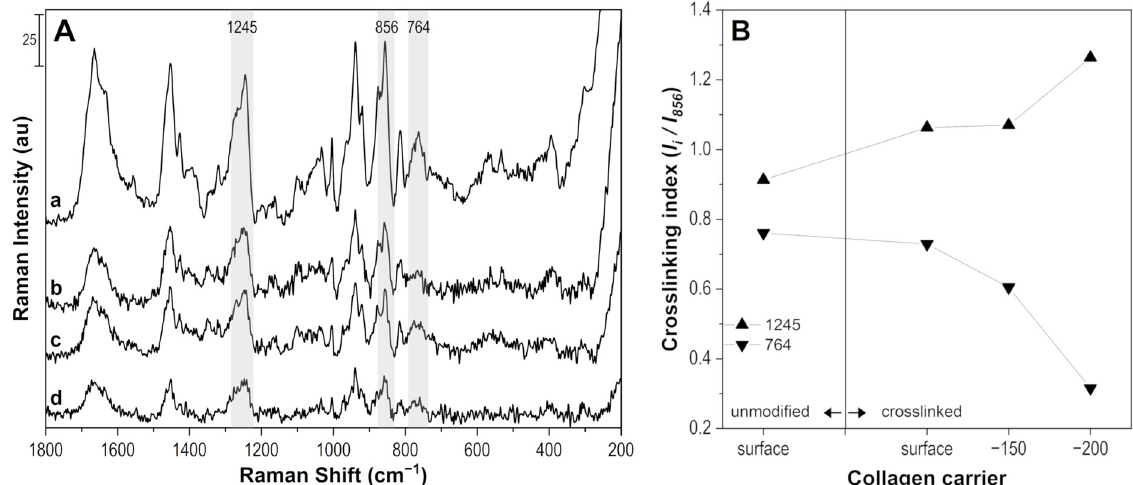
Figure 3. Raman spectra of swollen collagen carrier (a) unmodified, (b) crosslinked surface, (c) cross ‐ linked 150 μ m under the surface, and (d) 200 μ m under the surface of the carrier ( A — left ). Cross ‐ linking index obtained as I i /I 856 of un/modified carrier at given depth from the surface, the lines are only guides to the eye ( B — right ).